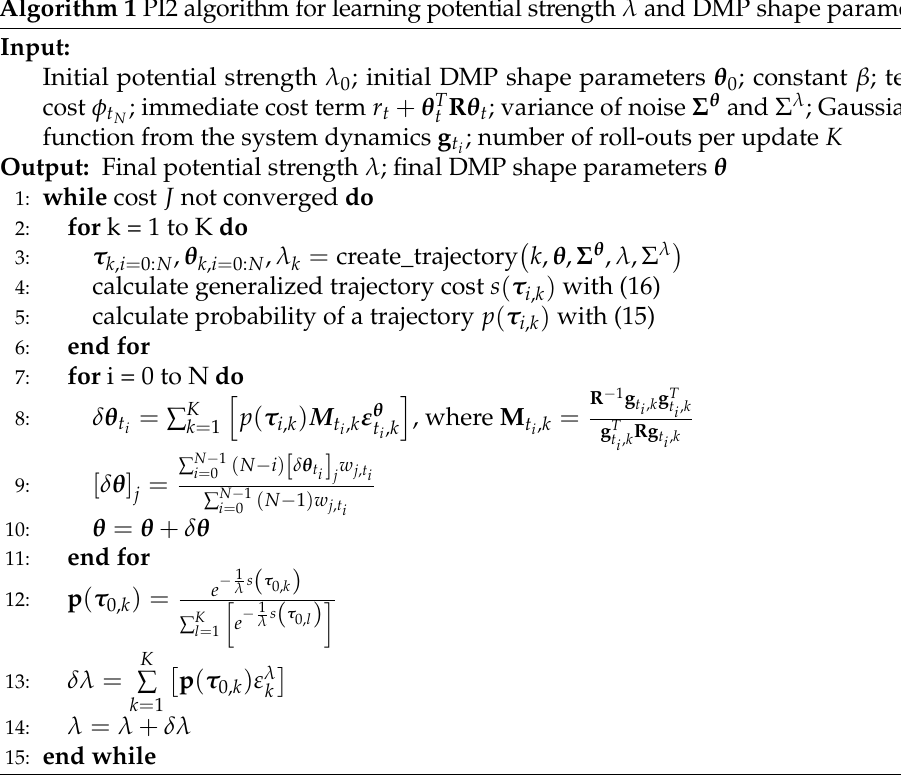
Algorithm 1 PI2 algorithm for learning potential strength λ and DMP shape parameters θ